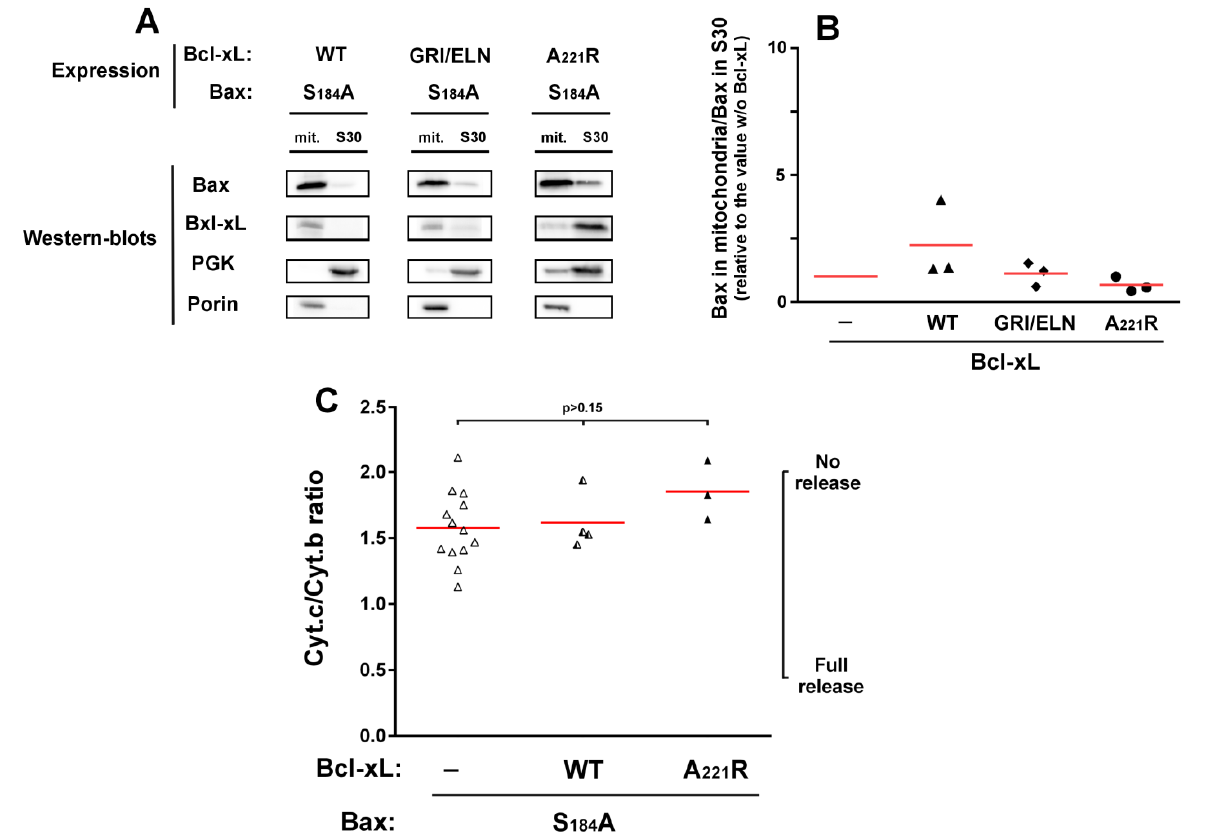
FIGURE 3: Effect of Bcl-xL on the localization and function of a non-phosphorylatable Bax mutant. Same conditions as in Figure 1, with Bax- S184A instead of